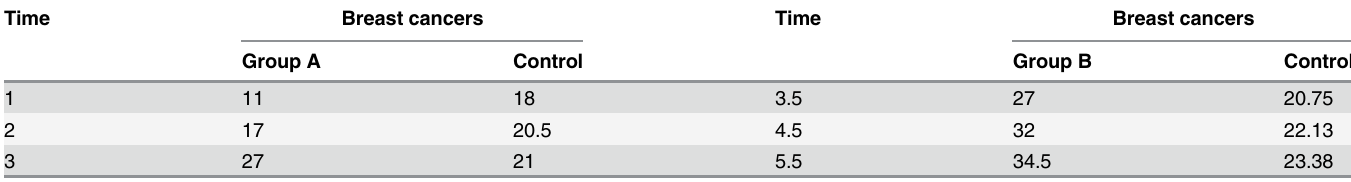
Table 1. (Scenario 1) The number of breast cancer cases in the intervention group for the short term users (Group A) and long term users (Group B). Time Breast cancers Time Group